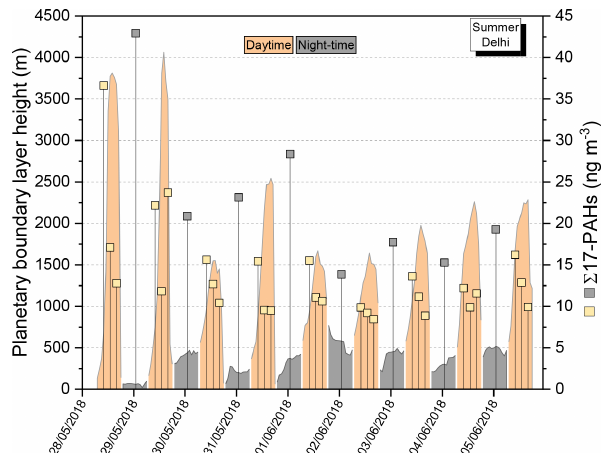
Figure 4. Planetary boundary layer height in summer Delhi 2018 (latitude 28.625, longitude 77.25; source: ECMWF ERA5 in 0.25 ◦ , 1h time resolution). Square symbols represent the temporal varia- tion of total PAHs in daytime and